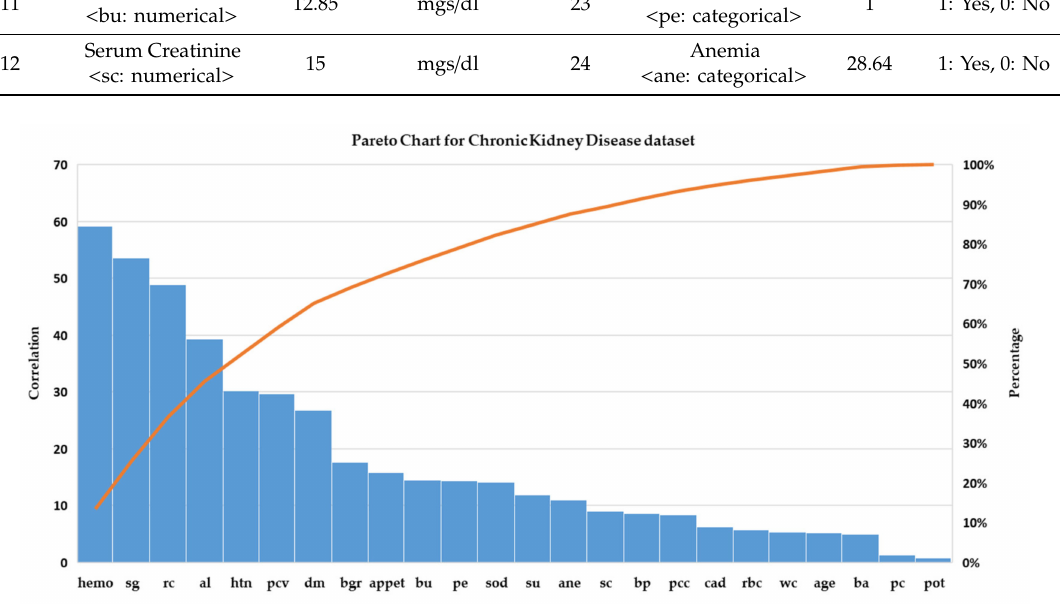
Figure 5. Pareto-chart of features in the Chronic Kidney Disease (CKD)